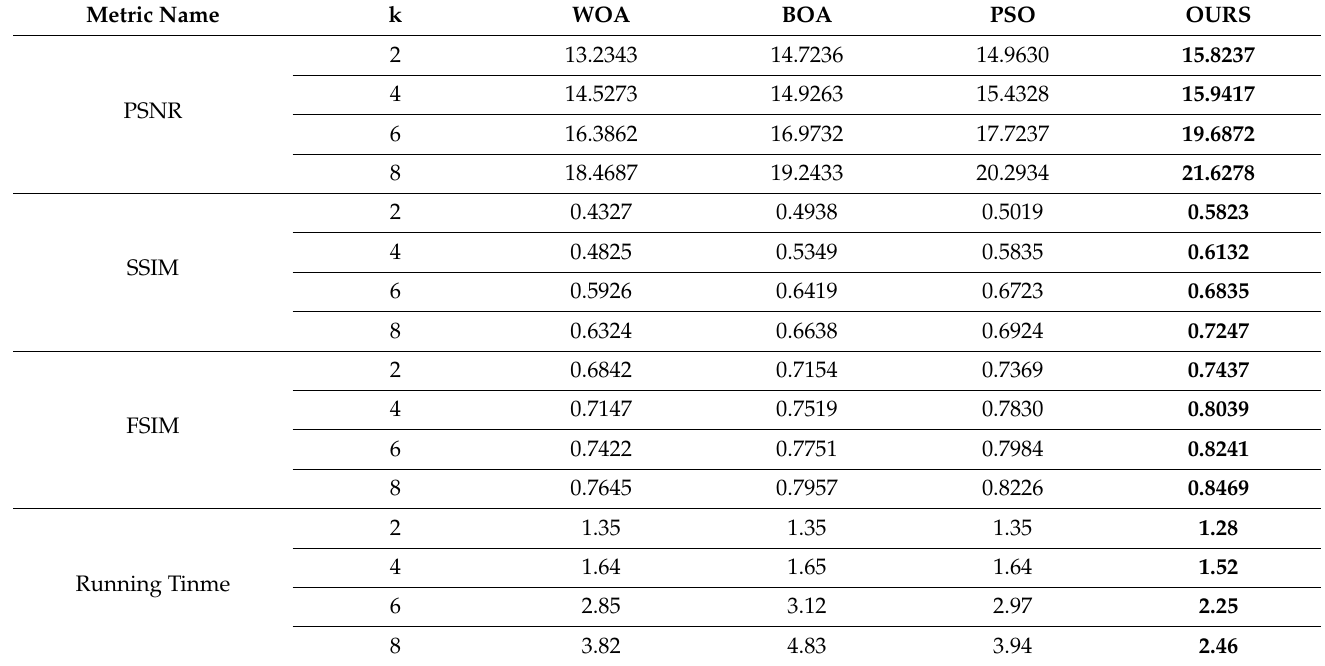
Table 11. Average of 100 image segmentation